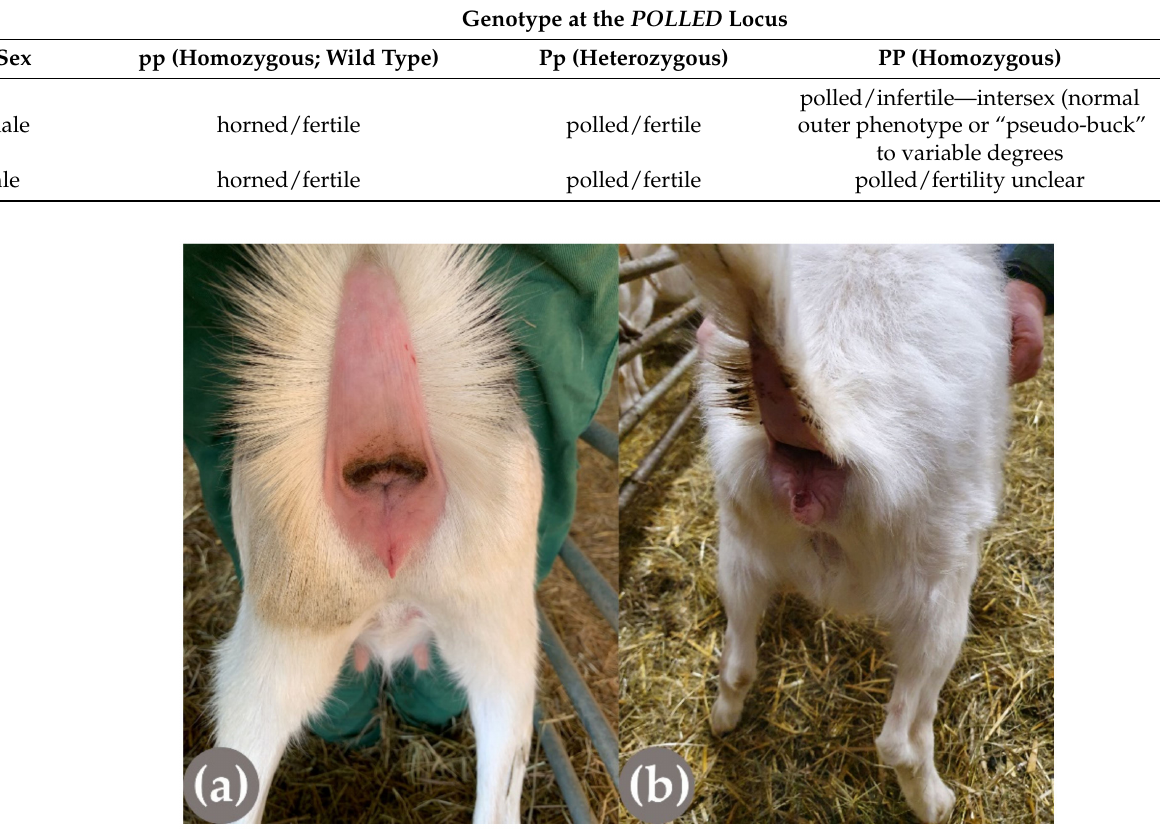
Figure 5. Comparison of the external genitalia of a normal ( a ) and PIS-affected ( b ) female (XX) homozygous polled Saanen